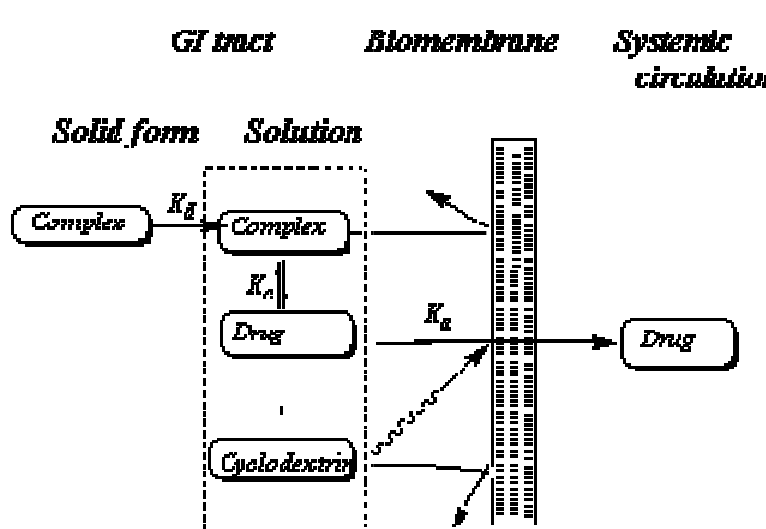
Figure 3. Factors affecting the drug absorption involving cyclodextrin Experimental